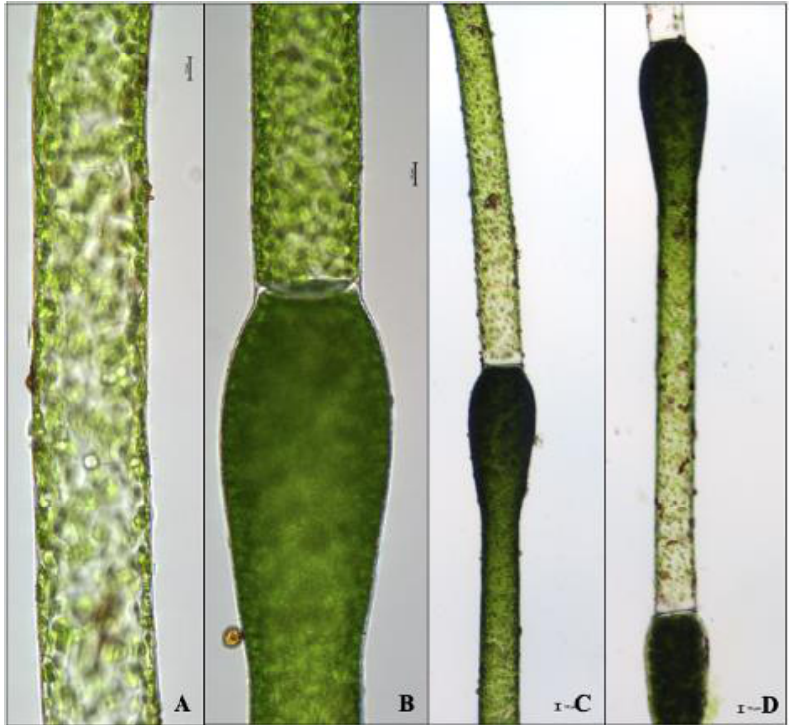
Figure 2. Characters of the principal filaments of Pithophora roettleri . ( A , B ) 400× magnification. ( C , D ) 100× magnification. ( A ) Single, parietal layer of chlorophyll granules. ( B – D ) Formation of intercalary akinetes on the upper end of vegetative cells. ( D ) Interspersed akinetes. Scale bar = 10 µm.